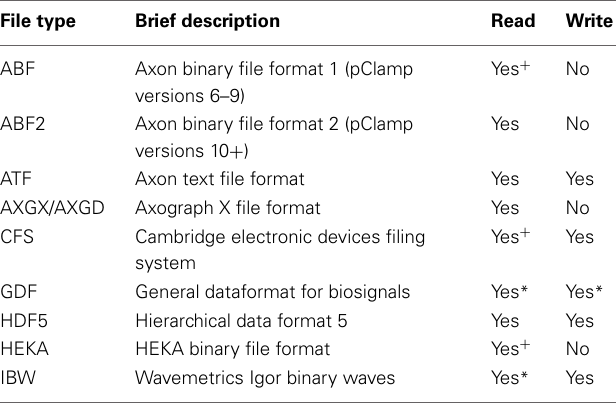
Table 1 | List of supported file